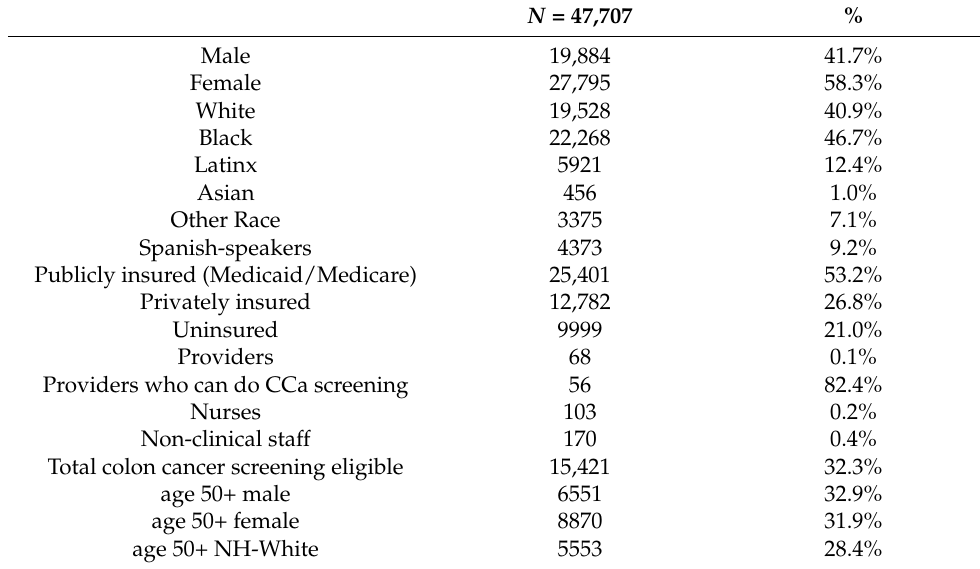
Table 2. FQHC baseline data